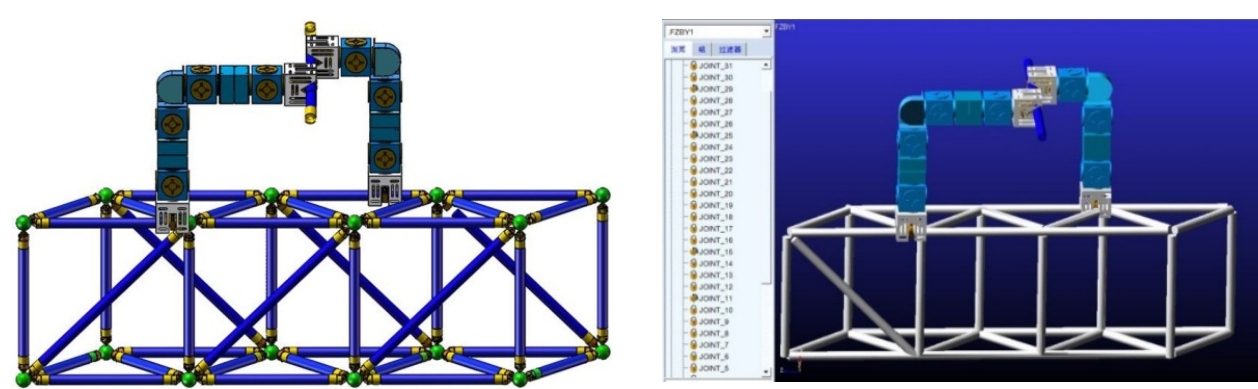
Figure 18. Robot joint constraint diagram. Table 5. Step function of main